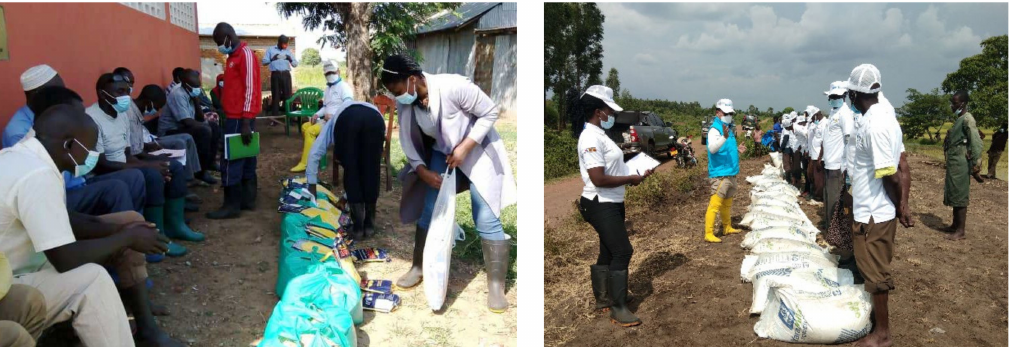
Figure 1. The Director KOPIA Uganda and his team distributing NARORICE-1 seed and fertilizer to project beneficiaries in the Doho rice scheme. The picture on the left is for the distribution of starter seeds to members of Namunasa Mixed farmers’ association who are engaged in community seed production, while the picture on the right shows the distribution of fertilizers to farmers.